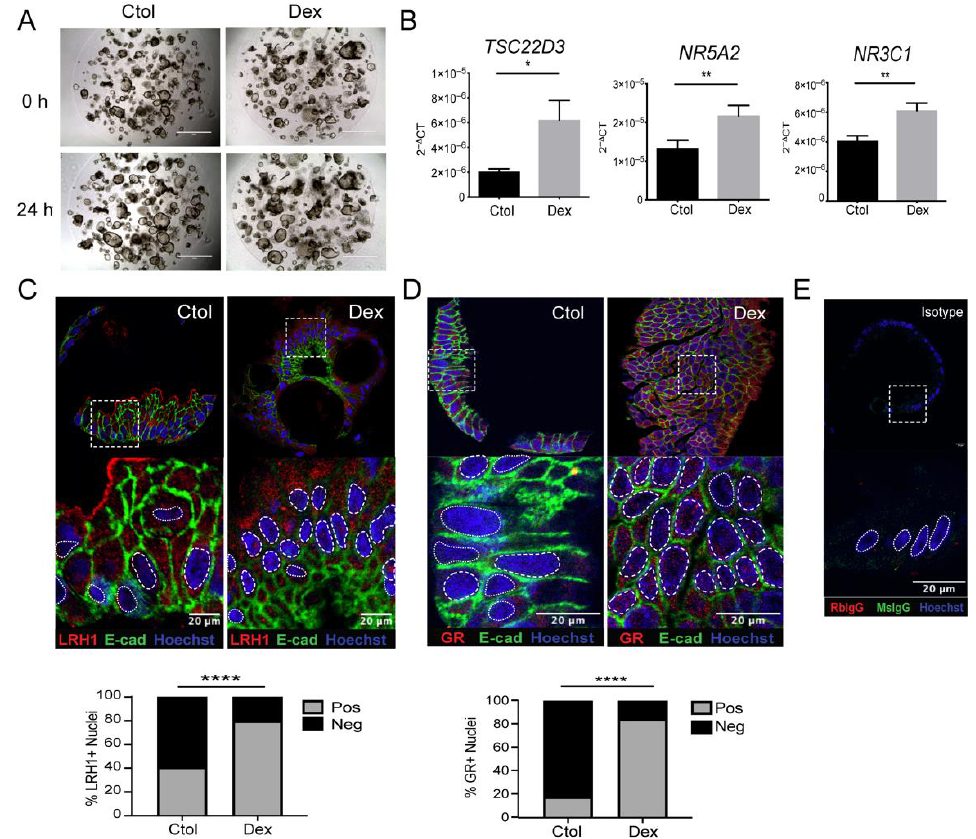
Figure 5. Dexamethasone induces LRH-1 in primary human intestinal organoids. Colonic organoids from healthy tissue were stimulated with 100 nM Dex for 24 h. ( A ) Organoids under light microscopy 4×. Scale bar 1000 um. ( B ) Organoids were analyzed for TSC22D3 ( left ), NR5A2 ( center ) and NR3C1 ( right ) transcript levels, relative to 18s rRNA. Paired t -test, * p < 0.05; ** p < 0.01; n = 3. Representative immunoreactivity of ( C ) LRH-1 and ( D ) GR with corresponding ( E ) IgG isotype control in paraffin-embedded PFA-fixed sections of colonic organoids stimulated with 100 nM Dex for 24 h. Percentage of positive and negative nuclear staining for ( C , bottom ) LRH-1 and ( D , bottom ) GR. E-cadherin (E-cad, green) was used for epithelium counterstain and Hoescht as nuclear stain, **** p < 0.0001. In zoomed image: whole organoid for context purposes. Dashed line: positive nuclear stain; dotted line: negative nuclear stain. Objective 40X. Scale bar 20 um.